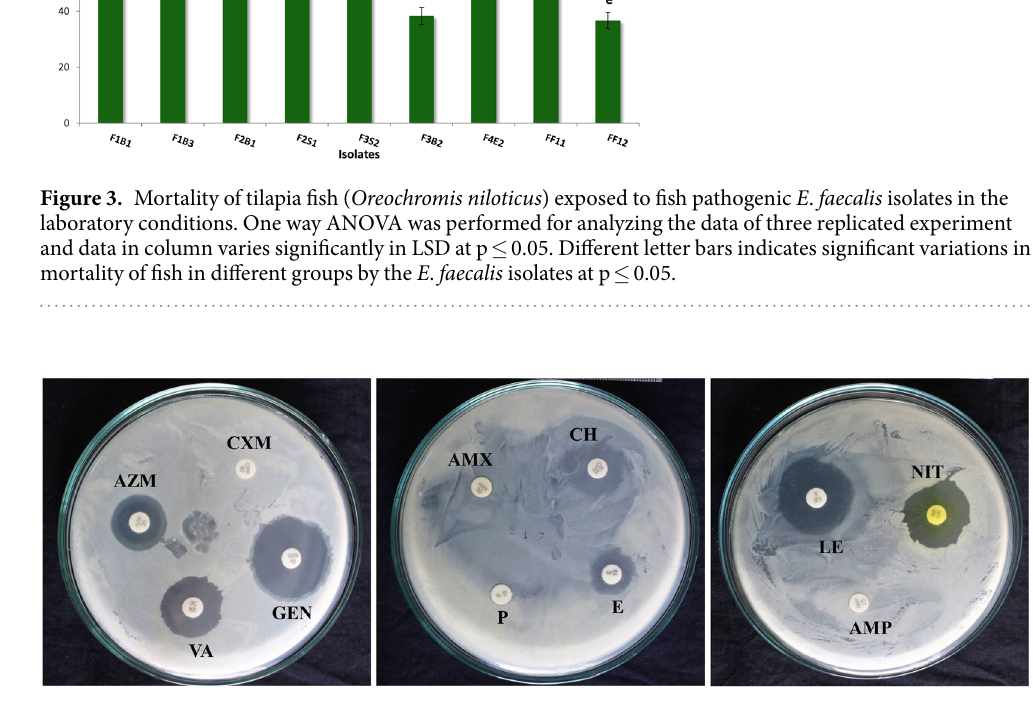
Figure 4. Antibiotic susceptibility profile of fish pathogenic E. faecalis FF11 against commercially available